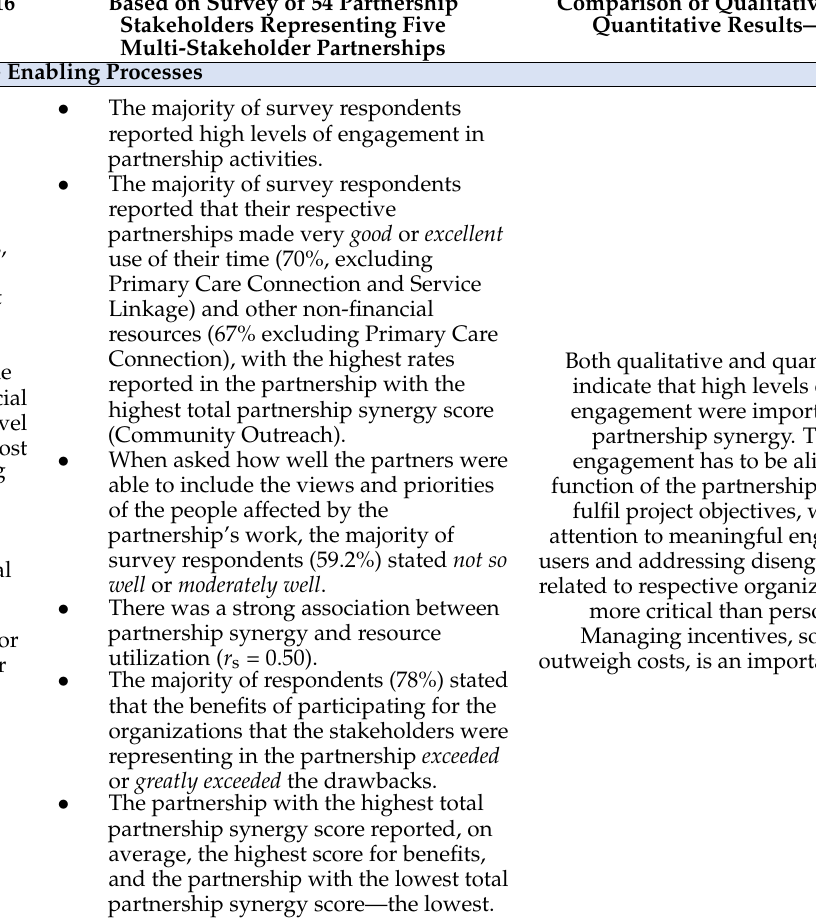
Comparison of Qualitative Findings and Quantitative Results—Comments